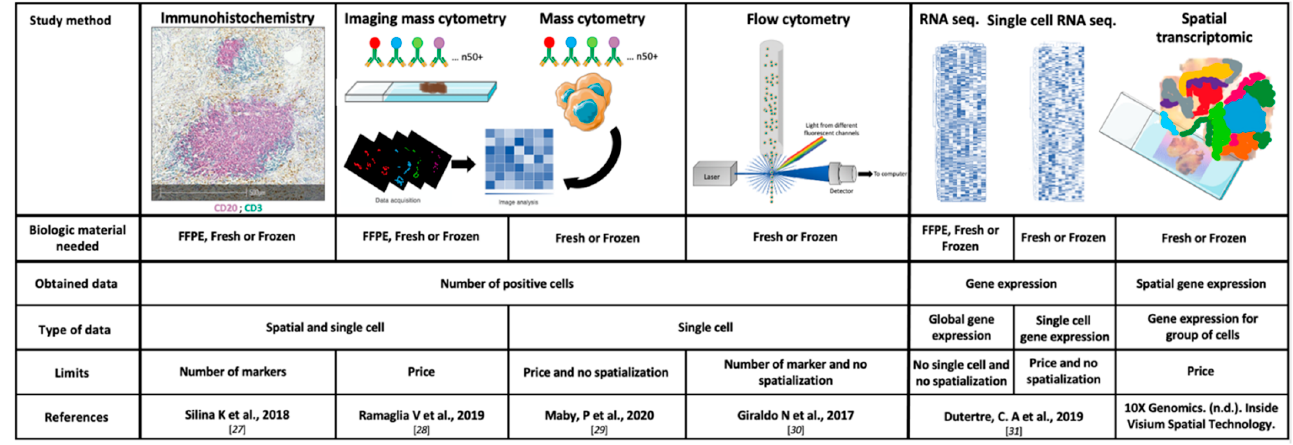
Figure 1. Technical characteristics of the main study methods of the tumor microenvironment. FFPE: Formalin-Fixed Paraffin-Embedded and RNA: ribonucleic acid.